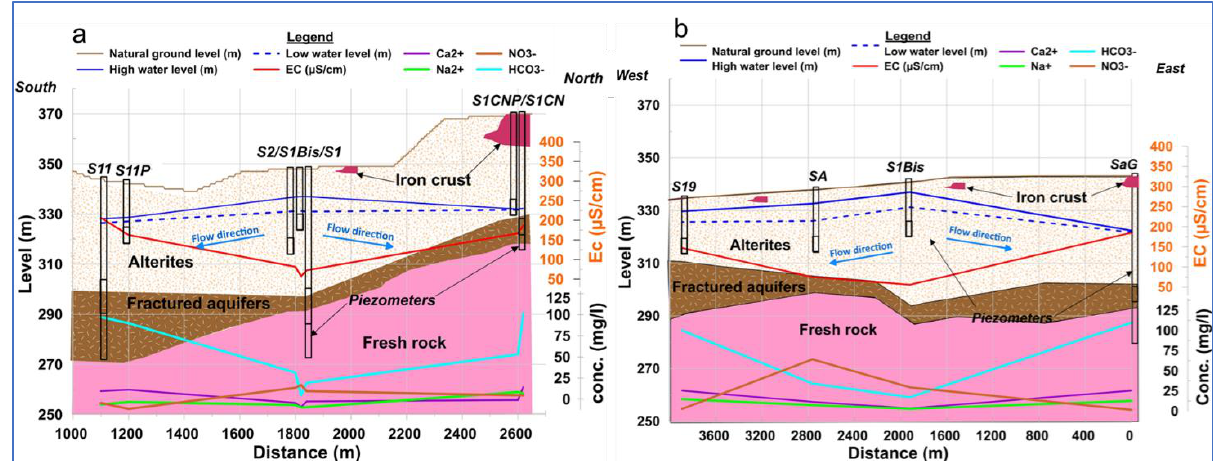
Figure 7. Spatial evolution of electrical conductivity and major ions along the two transects: ( a ) north – south transect and ( b ) west – east transect.